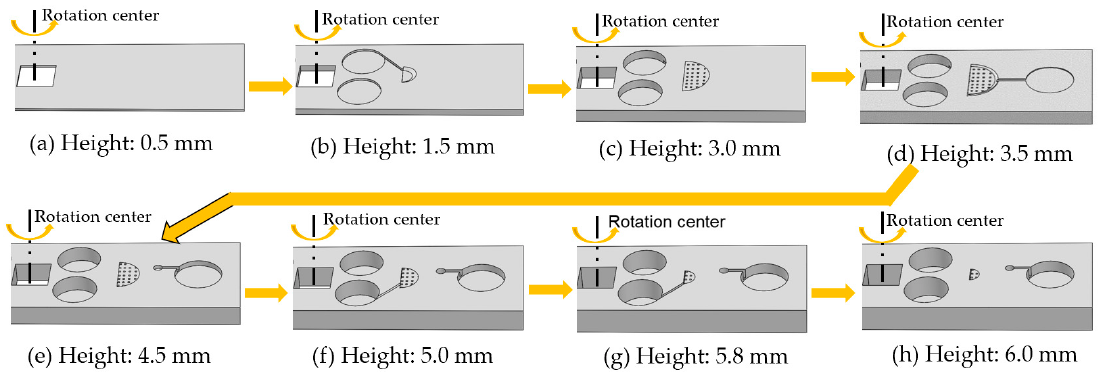
Figure 3. The flowchart of the additive manufacturing process for the jet mixer cartridge: ( a ) the substrate layer (height: 0.0–1.0 mm); ( b ) the mixing Chamber D layer (height: 1.0–2.5 mm); ( c ) the bottom nozzle layer (height: 2.5–3 mm); ( d ) the mixing Chamber E layer (height: 3.0–4.0 mm); ( e ) the top nozzle layer (height: 4.0–4.5 mm); ( e ) the mixing Chamber C layer (height: 4.5–6.0 mm); ( f ) the final geometry of the jet mixer before the cover was made; ( h ) the completed jet mixer. (Process 1-1: 0.0–2.5 mm; Process 2-2: 2.5–3.0 mm; Process 3-3: 3.0–4.0 mm; Process 4-4: 4.0–4.5 mm; Process 5-5: